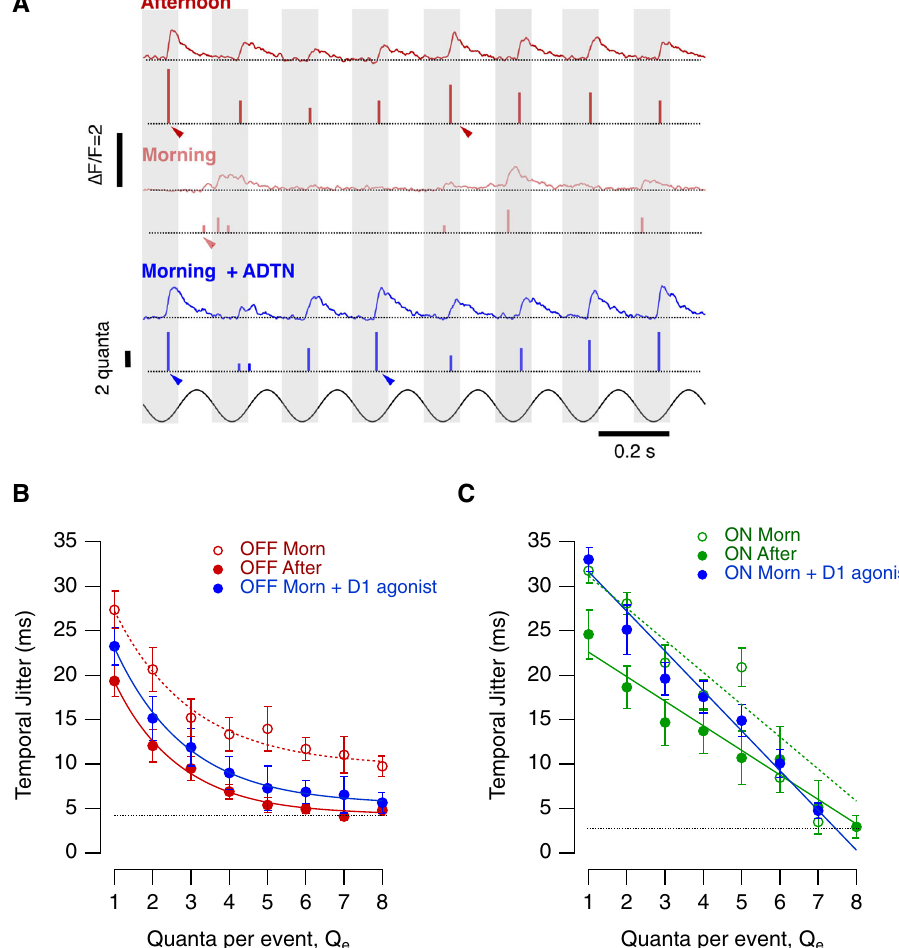
Fig. 6 The temporal precision of vesicle release is under diurnal control in the OFF channel. A Example recordings from two OFF synapses stimulated at 60% contrast in three conditions: afternoon (top, red trace), morning (middle, light red trace) and after intravitreal injection of ADTN in the morning (bottom, blue trace). Morning and morning + ADTN synaptic responses are from the same synapse. The modulation in intensity (5 Hz, sine wave) is shown below. Arrowheads highlight events occurring at different phases of the stimulus, with less variation with events composed for 4 or more quanta in the afternoon and after administration of ADTN in the morning. In each case the top trace shows the iGluSnFR signal and the lower trace the estimated Q e . B Temporal jitter of events composed of different numbers of quanta in OFF synapses in the afternoon (red dots; n = 24 synapses); Morning (open red dots; n = 19 synapses) and Morning + ADTN (blue dots, n = 16). Note that during the morning events composed by multiple quanta were less phase- locked to the stimuli in comparison to the afternoon. Activation of D1 receptors had a signi fi cant effect on release of multiquantal events. Events composed by 5 or more quanta jittered by ~5 ms, similar to values observed in the afternoon (black dashed line). The solid lines describing these relations in the three conditions are better described by a single exponential decay function of the form y 0 + A exp (( − ( x − x 0 )/ τ ))) with y 0 = 4.23 ± 1.2 and A = 27 ± 7 in the afternoon; y 0 = 9.77 ± 1.4 and A = 28.64 ± 5.6 in the morning and y 0 = 5.45 ± 1.3, A = 30 ± 6.1 after activation of D1 receptor in the morning. Each point shows the mean ± s.e.m. C Temporal jitter of events composed by different numbers of quanta measured in ON synapses in the afternoon (green dots; n = 14 synapses) during the morning (open green dots; n = 10 synapses) and during Morning + ADTN, (blue dots; n = 6 synapses). Activation of D1 receptor did not have a signi fi cant effect in the temporal precision in the ON channel. The relationships observed in the different conditions were better described by a straight line. Morning a = 34.7 ± 1.5 and a slope = − 3.6 ± 0.5; Afternoon: a = 25.1 ± 1.2 and a slope = − 2.8 ± 0.2; Morning + ADTN: a = 34.9 ± 1.5 and a slope = − 4.2 ± 0.3. Note that events composed of 8 or more quanta jittered by just ~4 ms (black dashed line). Each point shows the mean ± s.e.m. Source data are provided as a Source Data fi ON, with only 38% of release events being univesicular but again there was a signi fi cant shift towards larger events in the afternoon (Fig. 7D; p < 0.02). Blocking the D1 actions of endogenous MVR (Fig. 7) combine to alter the amount of visual information dopamine had a stronger effect in OFF synapses, increasing the transmitted by the synapses of bipolar cells? A larger signal rela- proportion of univesicular events to 66% in the afternoon tive to noise will tend to increase the mutual information (I) (Fig. 7E; p < 0.001). Qualitatively similar modulation of MVR was between the response ( Q ) and the stimulus generating it ( S ), observed over a range of contrasts from 20% to 80% and blocking although the size of the increase will depend on the statistical D1 receptors in the afternoon shifted the distribution back to properties of both signal and noise 40 . But how should we quantify the synaptic signal? When analyzing the spike code, all events univesicular release in both ON and OFF channels.